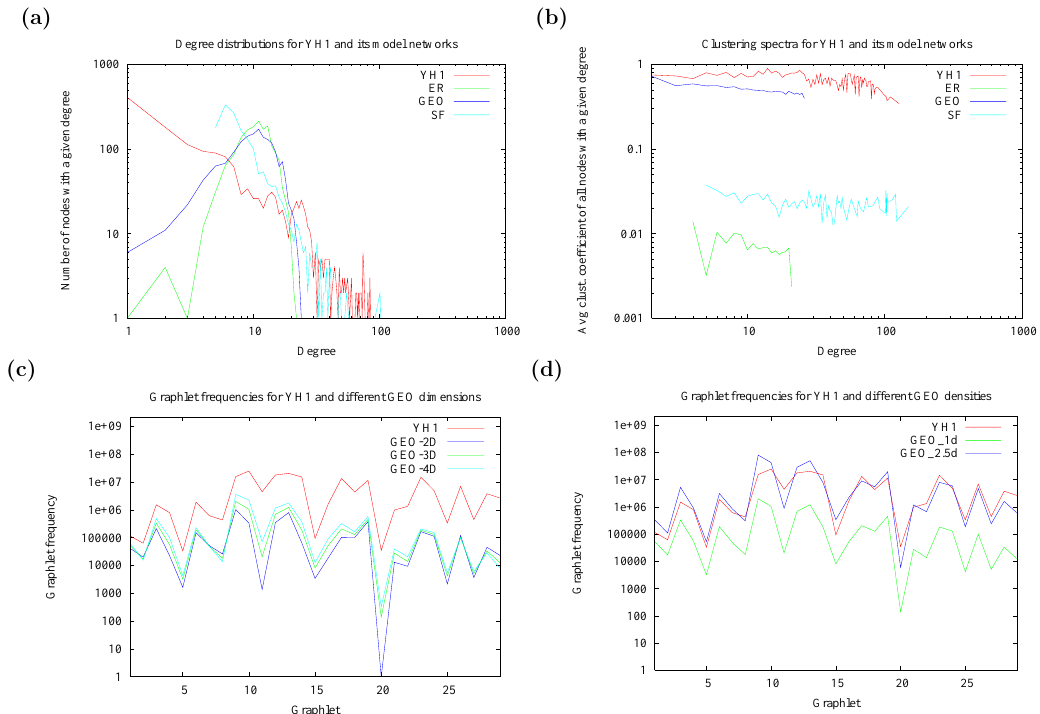
Figure S2: (a) Degree distributions and (b) clustering spectra for YH1, and an ER, a GEO, and an S F model network of the same size as YH1. (c) Graphlet frequencies for YH1, a 2-dimensional GEO (“GEO-2D”), a 3-dimensional GEO (“GEO-3D”), and a 4-dimensional GEO (“GEO-4D”) network of the same size as YH1. (d) Graphlet frequencies for YH1, a GEO network with the same number of nodes and edges as YH1 (“GEO 1d”), and a GEO network with the same number of nod es, but 2.5 times as many edges as YH1 (“GEO 2.5d”). On horizontal axes in panels c and d, graphlets are numbered as in Figure S1.